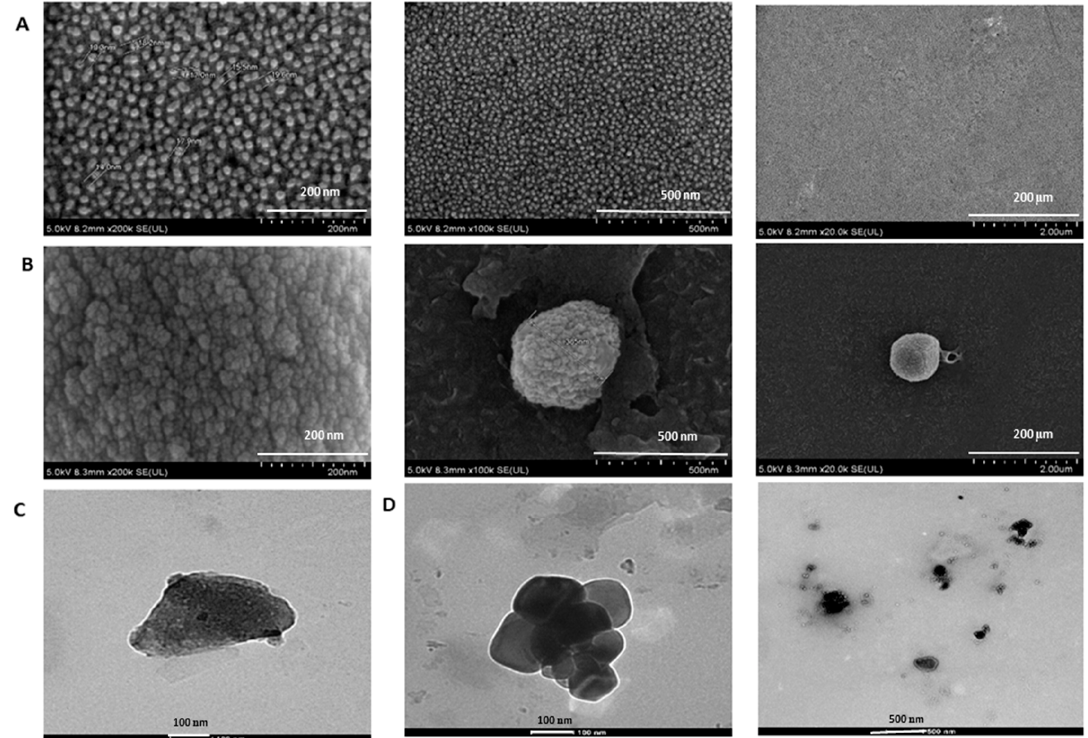
Figure 8. Morphological analysis of NaCNs through FESEM: ( A ) PTX-NaCNs ( B ) Negative Control (PTX + water). Scale bar: 200 nm, 500 nm and 2 µ m. Samples (10 µ L) were transferred to the glass cover and placed at room temperature until getting dried for FESEM analysis. Morphological analysis of NaCNs through HR-TEM: ( C ) Blank NaCNs ( D ) PTX-NaCNs. (Scale bars: 100 and 500 nm). Copper grid is suspended in the samples for 30 s, air-dried at room temperature and then analyzed through HR-TEM machine.